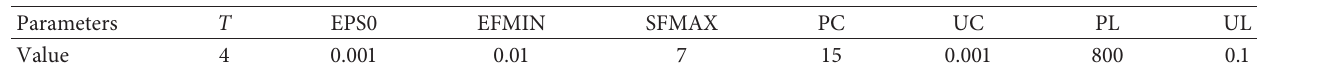
Table 4: Parameters of ∗ MAT_JOHNSON_HOLMGUIST_CONCRETE (card2).